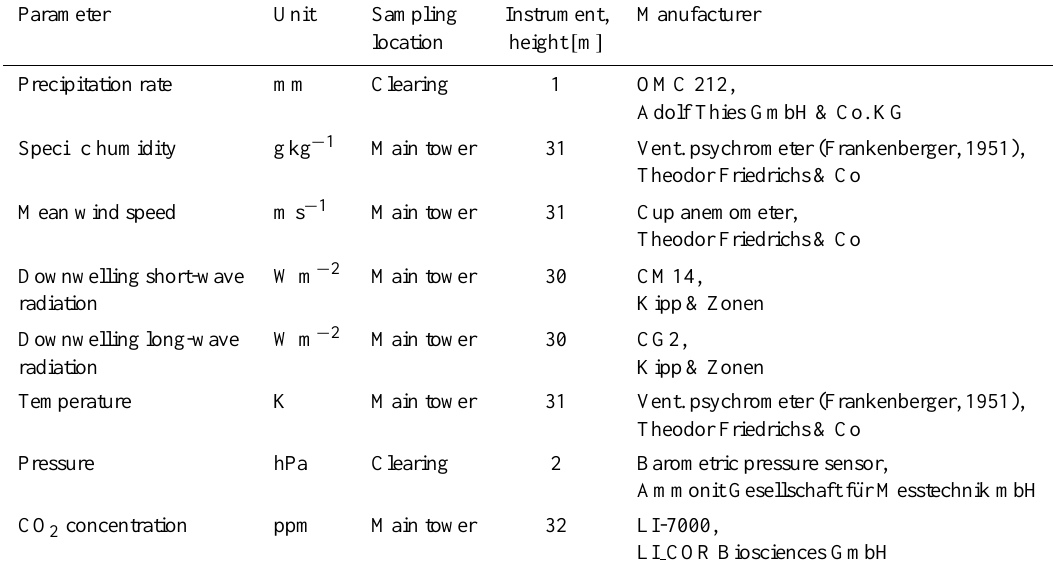
Table 1. Meteorological input parameters of the ACASA model and the corresponding measurements at the Waldstein-Weidenbrunnen site. Parameter Unit Sampling Instrument, Manufacturer location height [ m ] Precipitation rate mm Clearing 1 OMC 212, Adolf Thies GmbH&Co. KG Specific humidity gkg − 1 Main tower 31 Theodor Friedrichs&Co Main